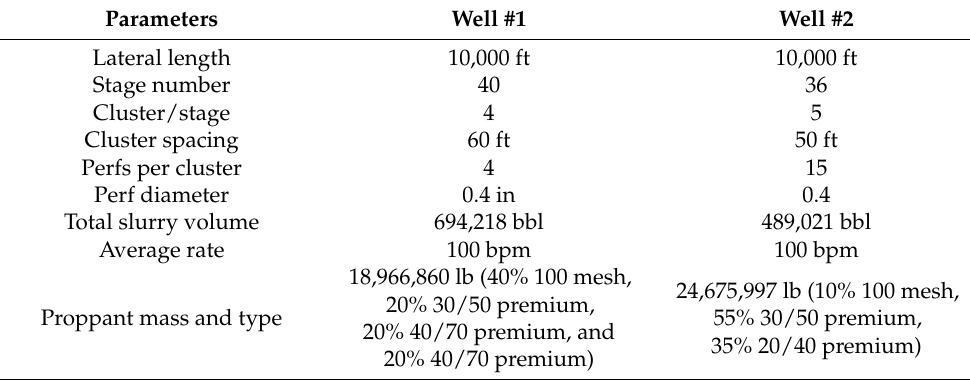
Table 1. Completion design and pumped treatment in Well #1 and Well